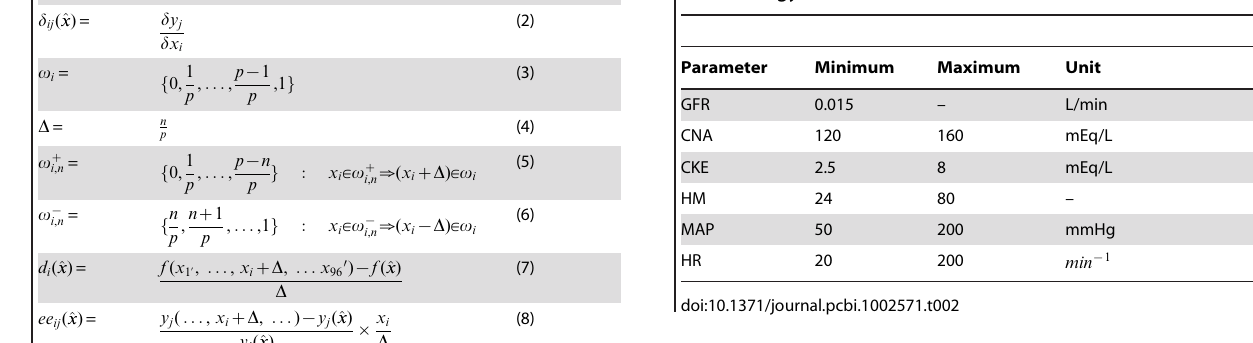
Table 1. Equations for calculating elementary effects. Table 2. The conditions on various model parameters that were used to ensure that the virtual person remained ‘‘alive’’ during a simulation, based on definitions from the Common Terminology Criteria for Adverse Events v4.03 (CTCAE) [41].